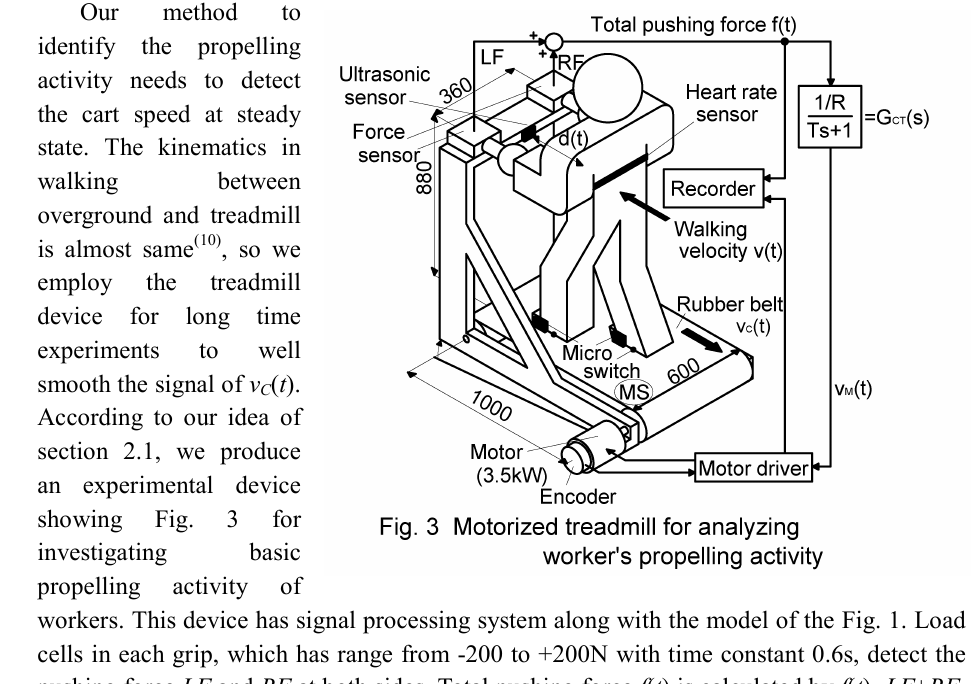
of workers. This device has signal processing system along with the model of the Fig. 1. Load cells in each grip, which has range from -200 to +200N with time constant 0.6s, detect the pushing force LF and RF at both sides. Total pushing force f ( t ) is calculated by f ( t )= LF + RF . ( s )[= G ( s ) G ( s )]. From Eq.(8) and (9), G The signal f ( t ) is input signal of G CT R M by next Eq.